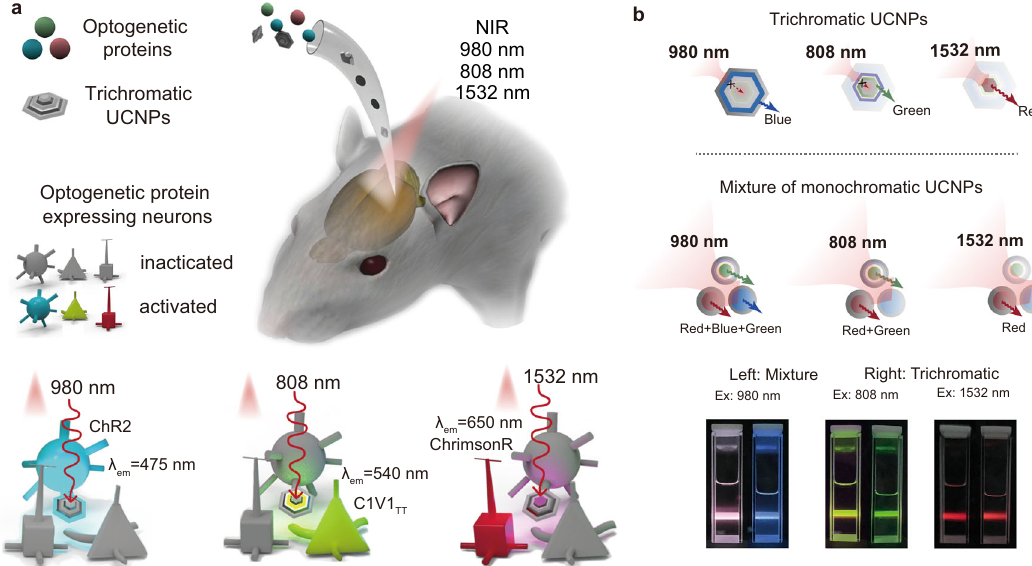
Fig. 1 Modulation of multiple neuronal population with trichromatic UCNPs. a Schematic showing NIR trichromatic upconversion mediated multicolor optogenetics. Channelrhodopsins and trichromatic UCNPs were introduced into speci fi c brain areas. 980, 808, and 1532 nm NIR light can penetrate brain tissue and excite the trichromatic UCNPs respectively, which would emit corresponding 475, 540, and 650 nm visible color and activate the matching neuronal population. b Schematic showing the CW NIR excited multicolor emission of trichromatic UCNPs and the mixture of monochromatic UCNPs